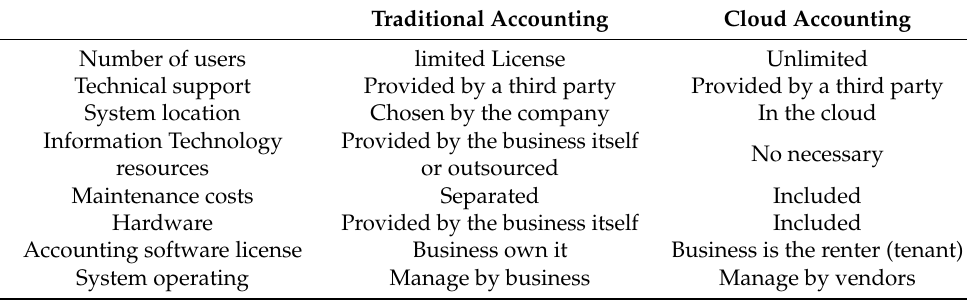
Table 1. Comparison between Traditional accounting and cloud accounting Solutions. Traditional Accounting Cloud